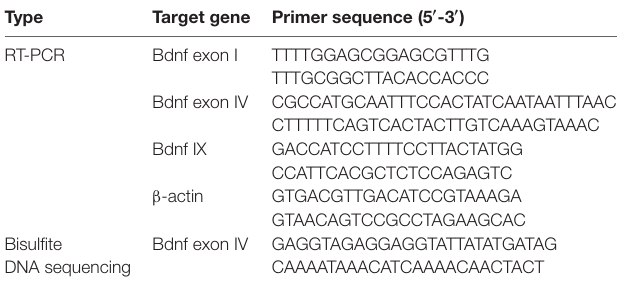
TABLE 1 | Primers used in gene expression and DNA methylation assays. Type